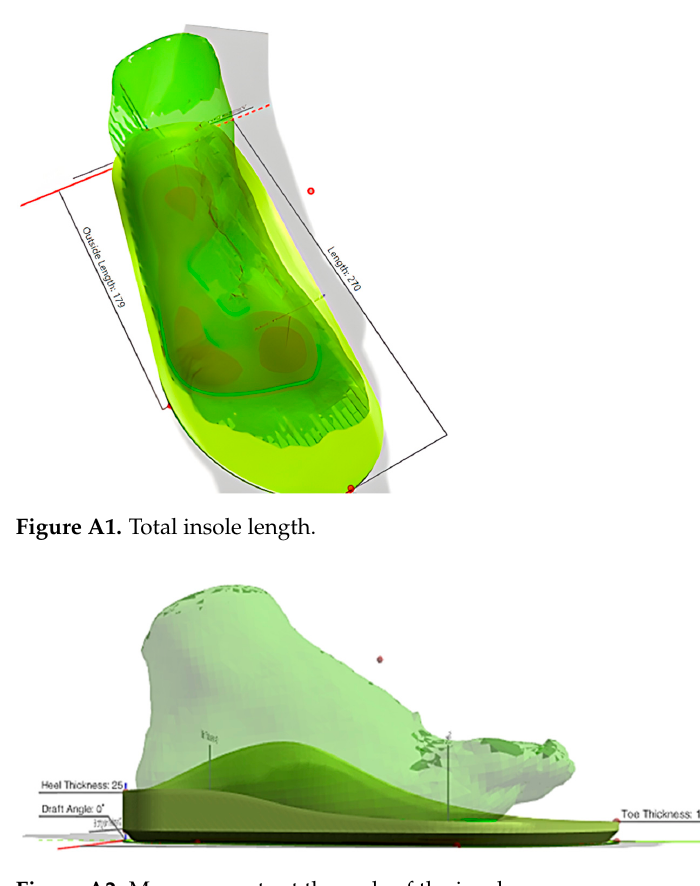
Figure A2. Measurements at the ends of the insole.